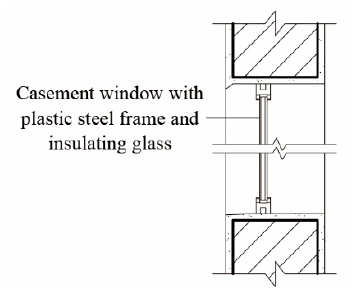
Figure 32. Replacing with a new window.